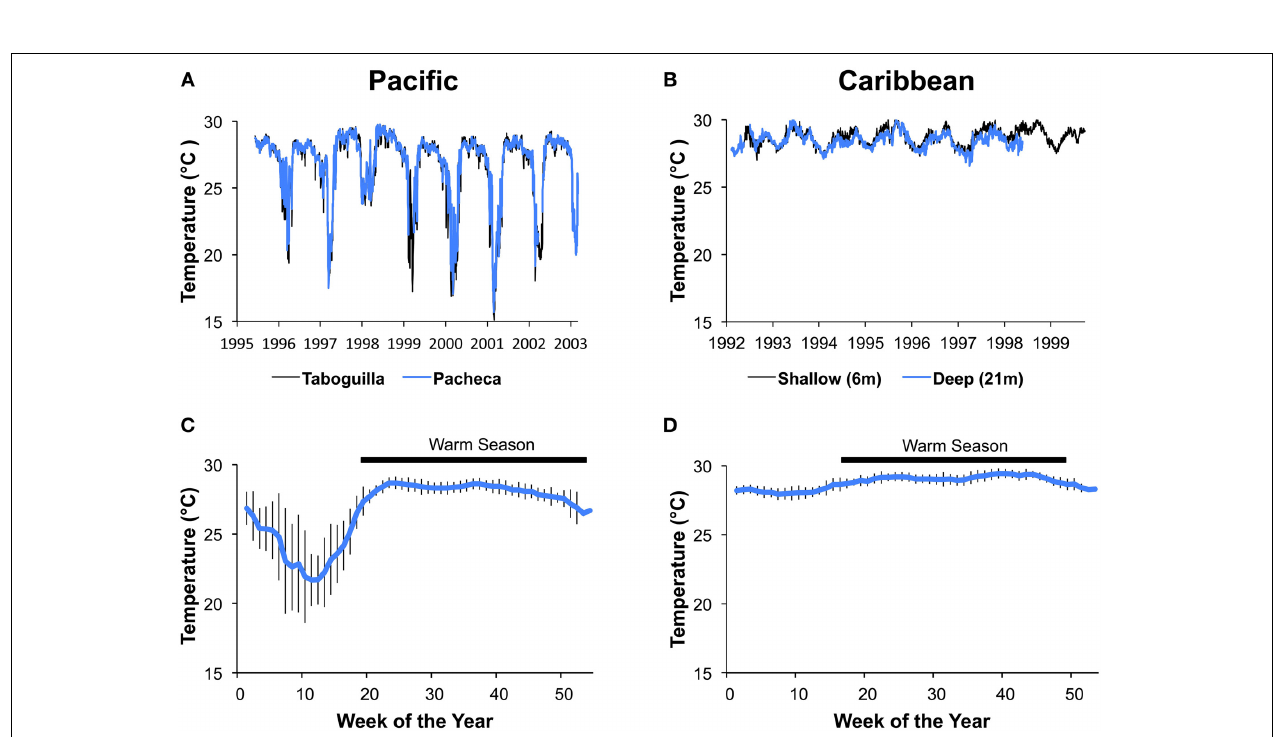
FIGURE 3 | Variation in water temperature at the Caribbean and Pacific study sites. Average daily temperatures for Islas Taboguilla and Pacheca in the Pacific (A) and average daily temperatures for 2 depths at Punta de San Blas (B) show clear seasonal patterns across years. Temperatures averaged across years for the same